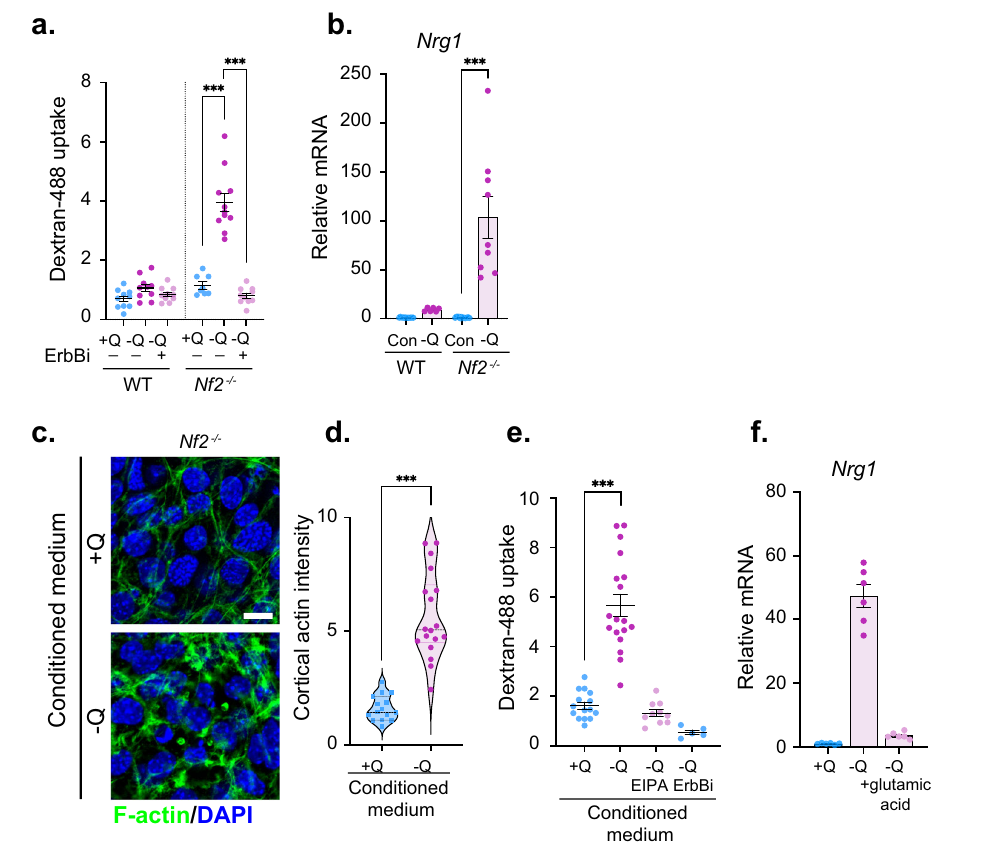
Fig. 4 | Nf2 − / − SCs enact a distinct feedforward autocrine Nrg1 − signaling pro- gram upon nutrient deprivation. a Macropinocytic dextran-488 uptake in WT and Nf2 − / − SCs in response to 24h glutamine deprivation with and without treat- ment with 2 µ M ErbBi. Data points aregraphedfor n =10(WT,all conditions), n =8 ( Nf2 − / − , +Q), n =11 ( Nf2 − / − , − Q), or n =10 ( Nf2 − / − , − Q/ErbBi) cells and lines represent mean±SEM. b Levels of Nrg1 mRNA in WT and Nf2 − / − SCs grown for 24h in com- plete medium or glutamine-deprived medium ( − Q). Data are presented as mean± SEM relative to WT mRNA levels for n =3 replicates. c Confocal images of F-actin depicting cortical ruf fl ing in Nf2 − / − SCs stimulated for 10min with conditioned medium from glutamine-deprived ( − Q) but not glutamine replete (+Q) Nf2 − / − SCs. Scalebar,10 µ m. d Violinplotdepictingcorticalactinfromcellsin c .Datapointsare